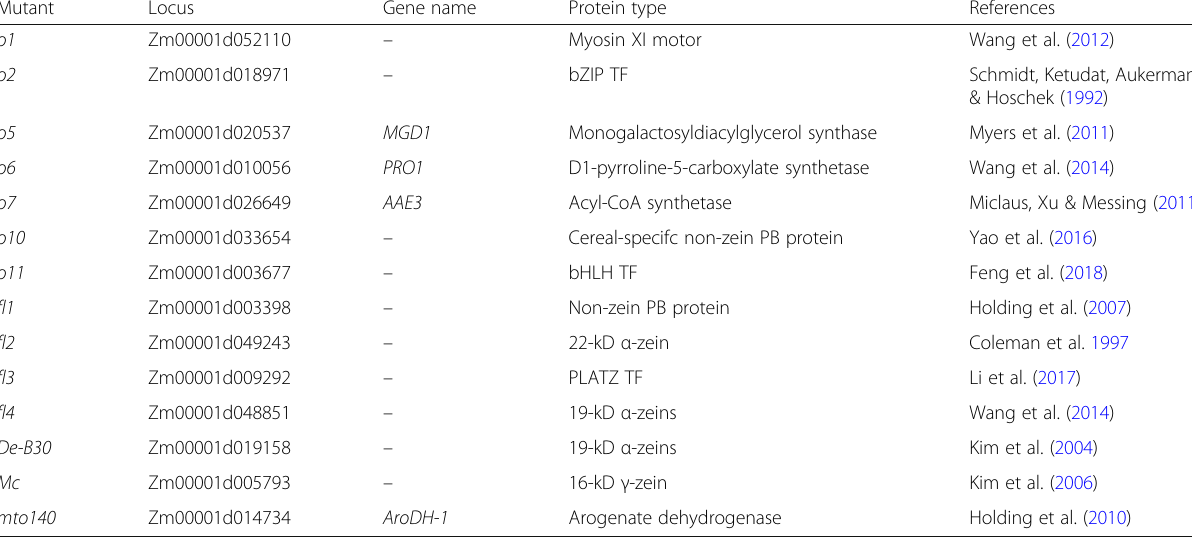
Table 1 List of maize opaque endosperm mutants identified and characterized so far. Modified from Zhang, Zhan & Yadegari (2018) Mutant